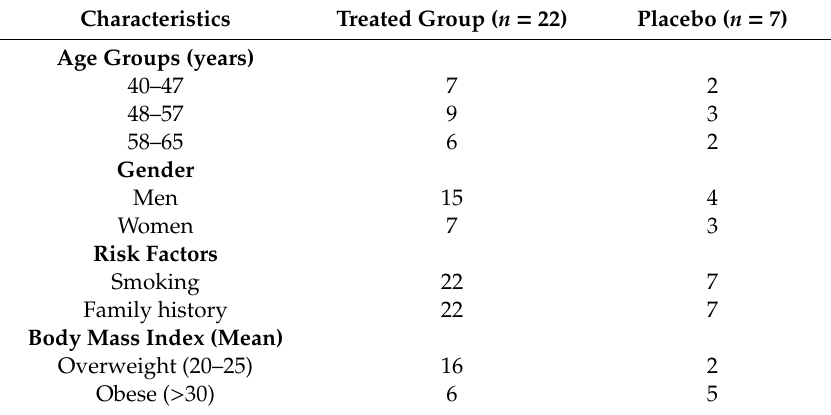
Table 2. Demographic characteristics of the sampled